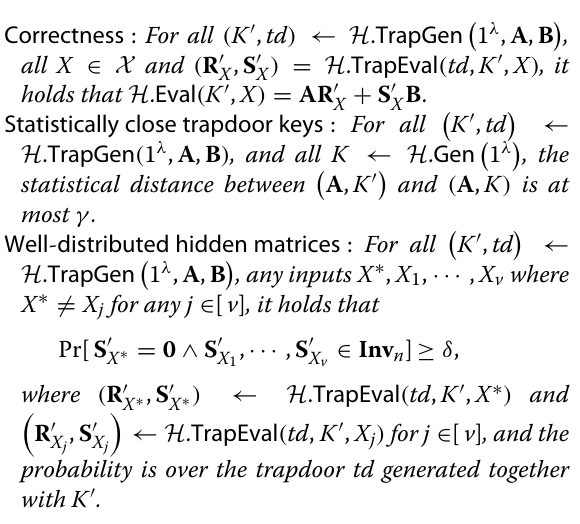
Lattice-Based Programmable Hash Function with High Min-Entropy